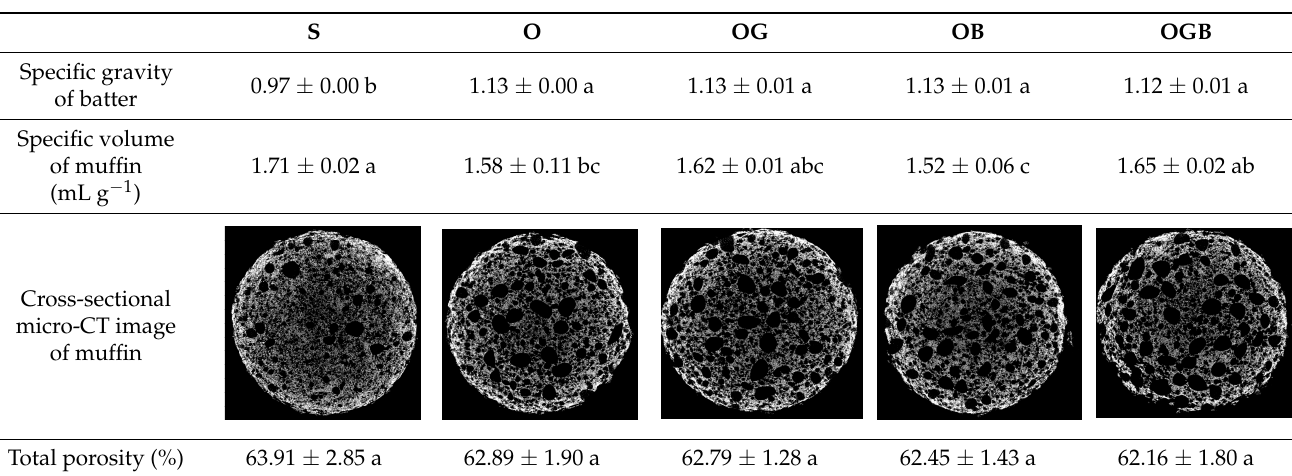
Table 1. Effect of shortening replacement with oleogles on the specific gravity of muffin batter and specific volume, cross-sectional micro-CT images, and total porosity of muffins.